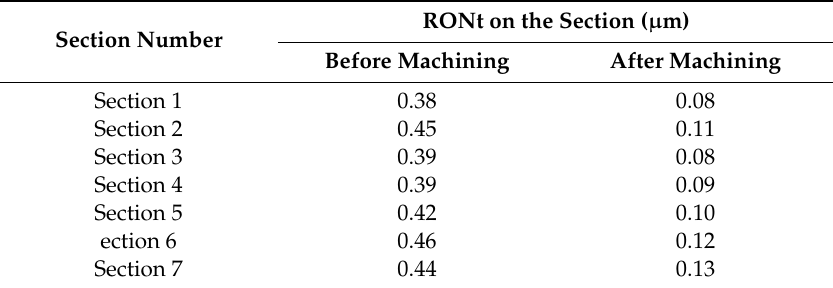
Table 4. RONt of corresponding circular section before and after machining.